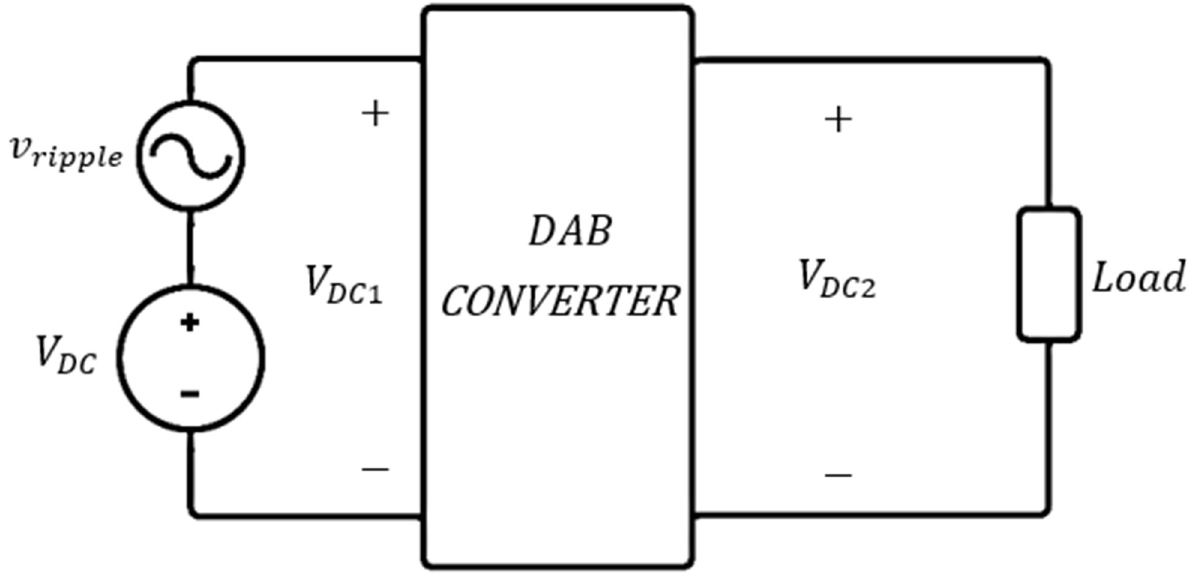
Figure 14. The circuit to emulate the fluctuation of input voltage of DAB converter.